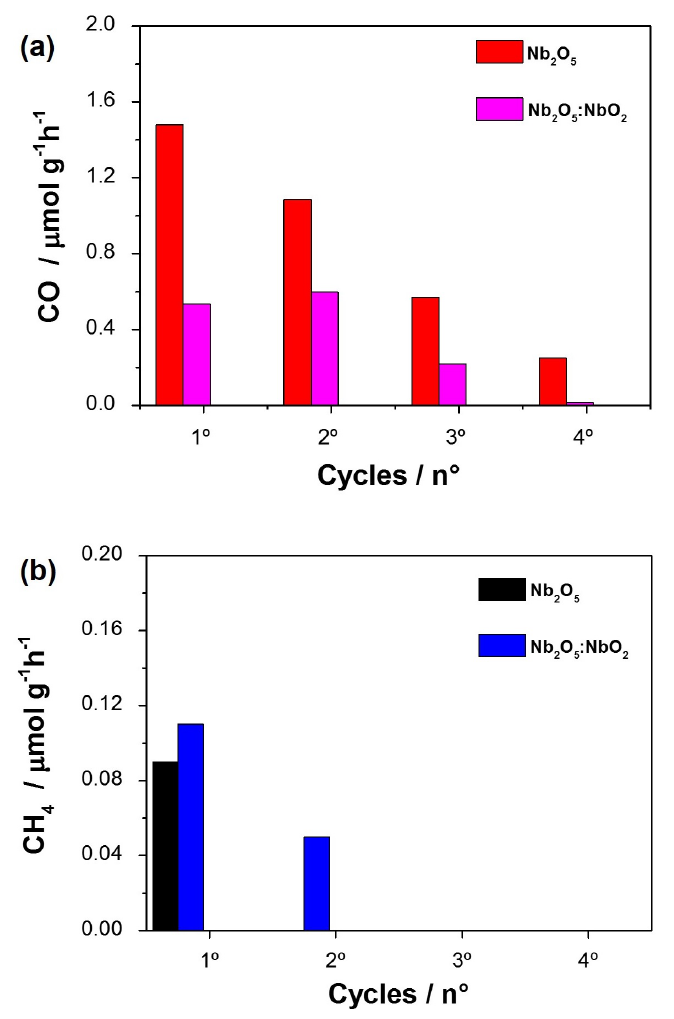
Figure 7. CO 2 conversion rate into ( a ) CO and ( b ) CH 4 products after a period of 6 h under UV-C irradiation, during four consecutive